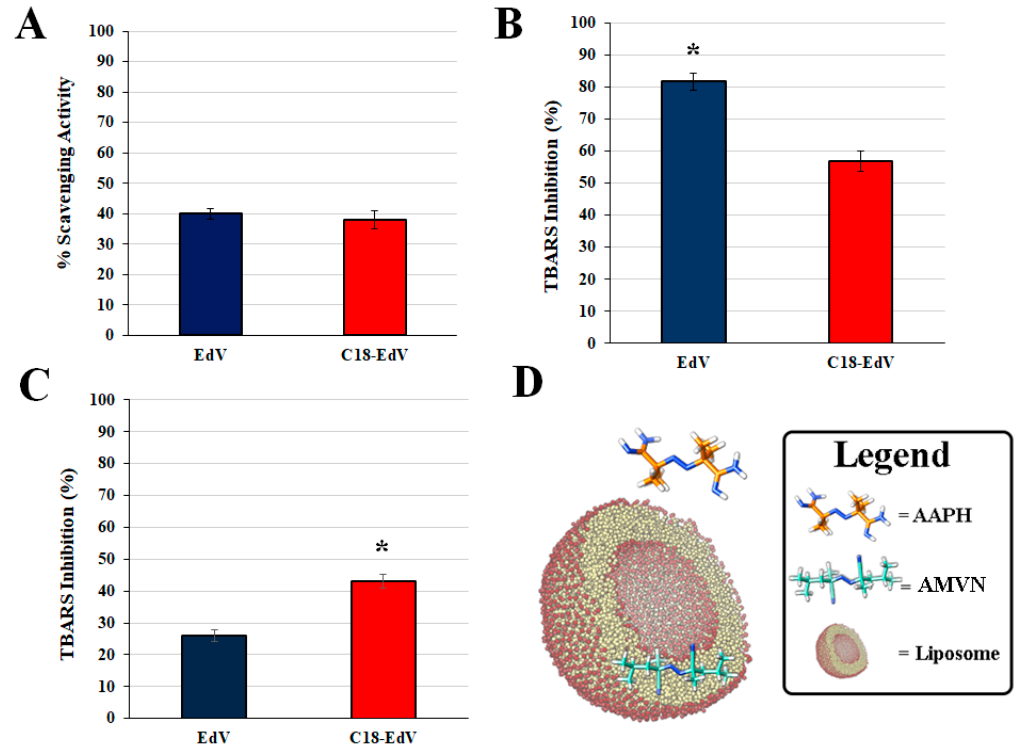
Figure 2. Antioxidant activity of edaravone (EdV) and C18-edaravone (C18-EdV) determined by means of different assays. DPPH free radical scavenging activity ( A ); percentage (%) of inhibition by Thiobarbituric acid reactive substances (TBARS) formation in phosphatidylcholine (PC) (3 mm) liposomes peroxidation by EdV or C18-EdV (0.06 mm) induced by 2,2-azobis (2-amidinopropane hydrochloride) (AAPH) (5 mm) ( B ) or 2,2-azobis(2,4-dimethylvaleronitrile) AMVN (1 mm) ( C ); schematic representation of water-soluble AAPH and lipid-soluble AMVN localization in a PC-liposome ( D ). Results are expressed as the mean ± standard deviation ( n = 3). * p < 0.001.